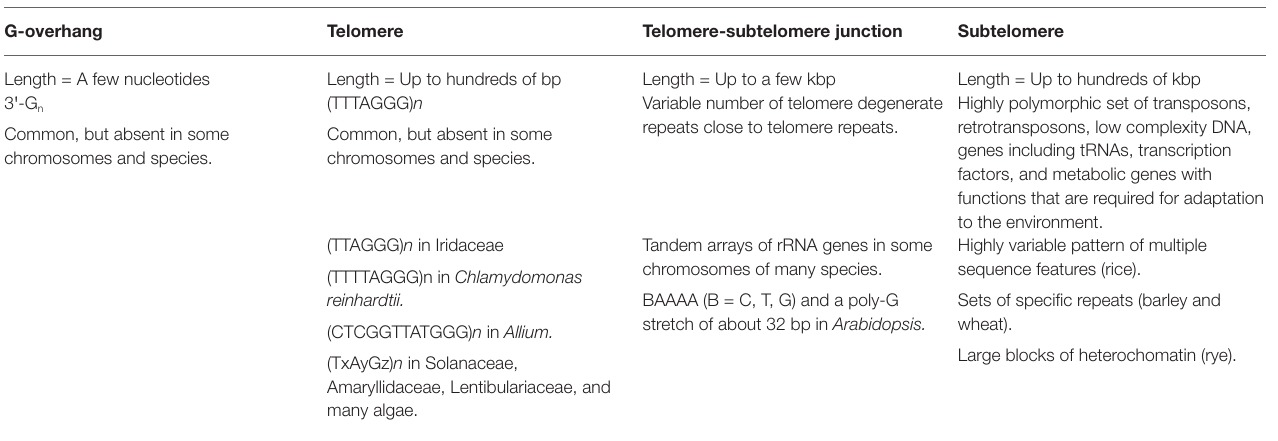
TABLE 1 | General features of chromosome